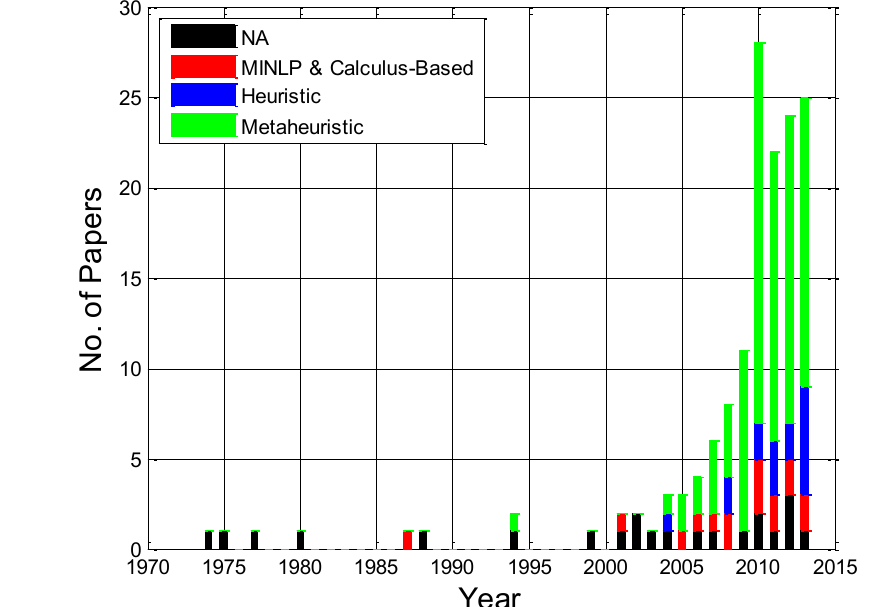
Figure 4. Type of solution methods used in the WFDO